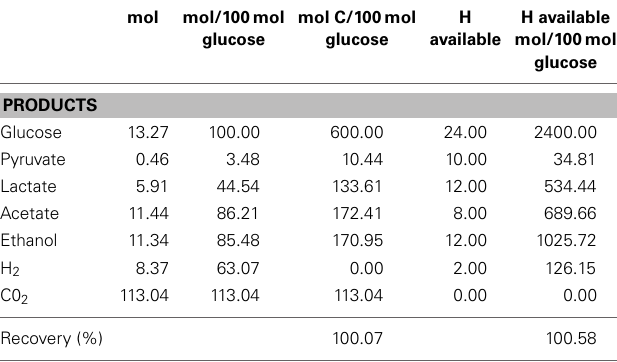
Table 2 | Stoichiometry of fermentation of endogenous polyglucose and the fermentation mass balance of L. aestuarii strain BL J, after 24h of dark